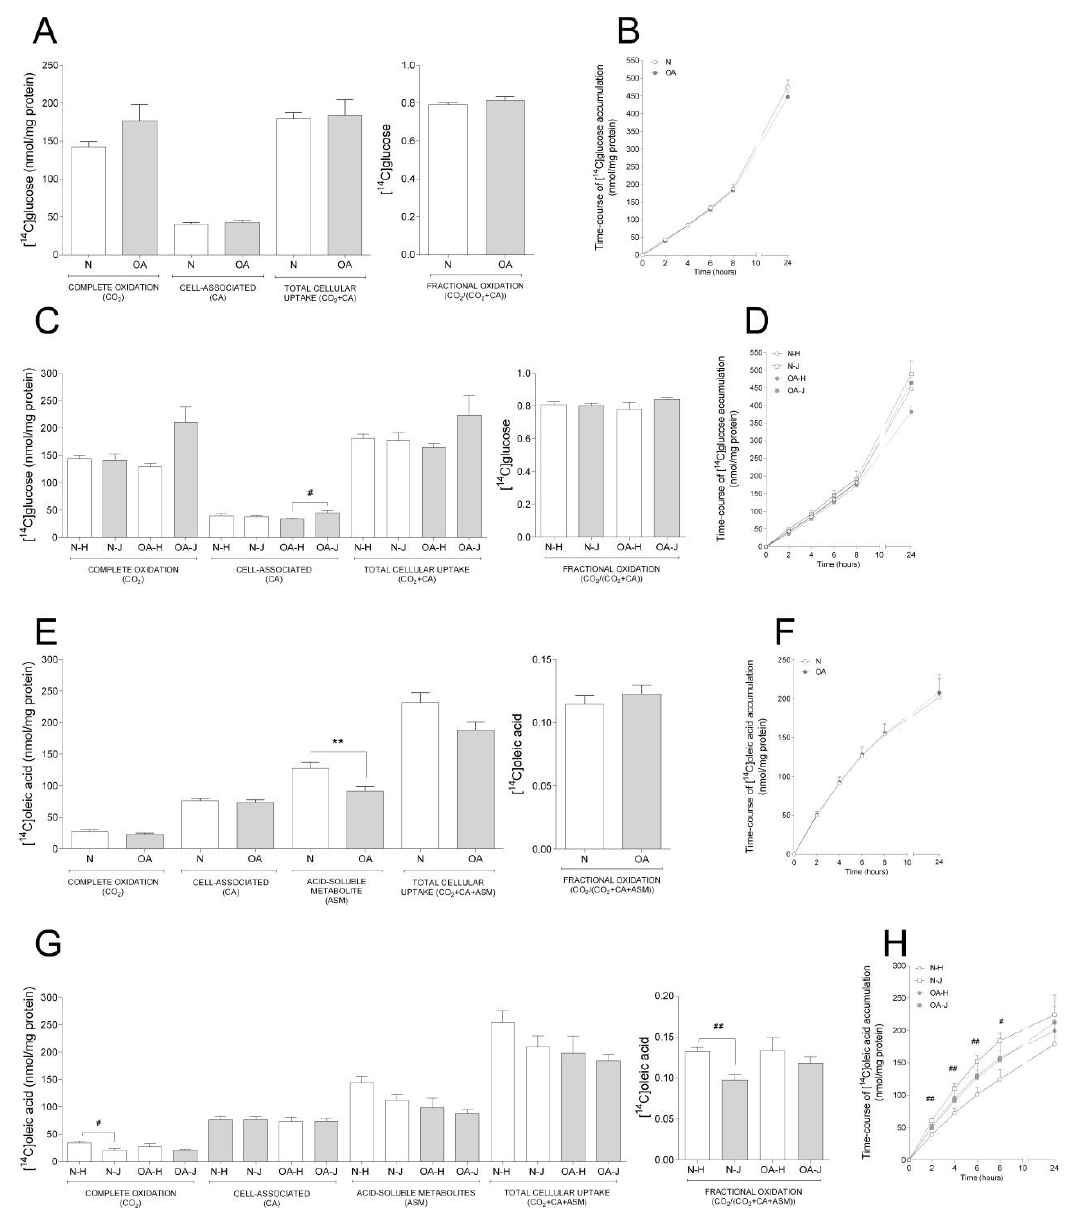
Figure 1. Basal glucose and fatty acid metabolism. Cybrids were cultured for 48 h in DMEM-glu (A–D, i.e., DMEM 5.5 mM glucose) or DMEM-ole (E–H, i.e., DMEM no glucose supplemented with 100 µ M oleic acid). Thereafter, basal glucose and oleic acid metabolism were evaluated using D-[ 14 C(U]glucose (0.5 µ Ci / mL, 200 µ M) or [1- 14 C]oleic acid (0.5 µ Ci / mL, 100 µ M), respectively, and 4 h substrate oxidation assay (A, C, E, and G) or 24 h SPA (B, D, F, and H). ( A , B ) Basal glucose metabolism in healthy (N) and osteoarthritic (OA) cybrids. ( C , D ) Basal glucose metabolism in cybrids carrying haplogroups H or J. ( E , F ) Basal oleic acid metabolism in N and OA cybrids. ( G , H ) Basal oleic acid metabolism in cybrids carrying haplogroups H or J. N and OA data included the values for haplogroups H and J combined. All data were obtained from three independent experiments, each with four replicates and two clones per donor. Values are presented as mean ± SEM in nmol / mg protein. * Statistically significant di ff erence between N and OA cybrids (** p ≤ 0.005, unpaired t -test). # Statistically significant di ff erence between haplogroups ( # p ≤ 0.05, ## p ≤ 0.005, Mann–Whitney